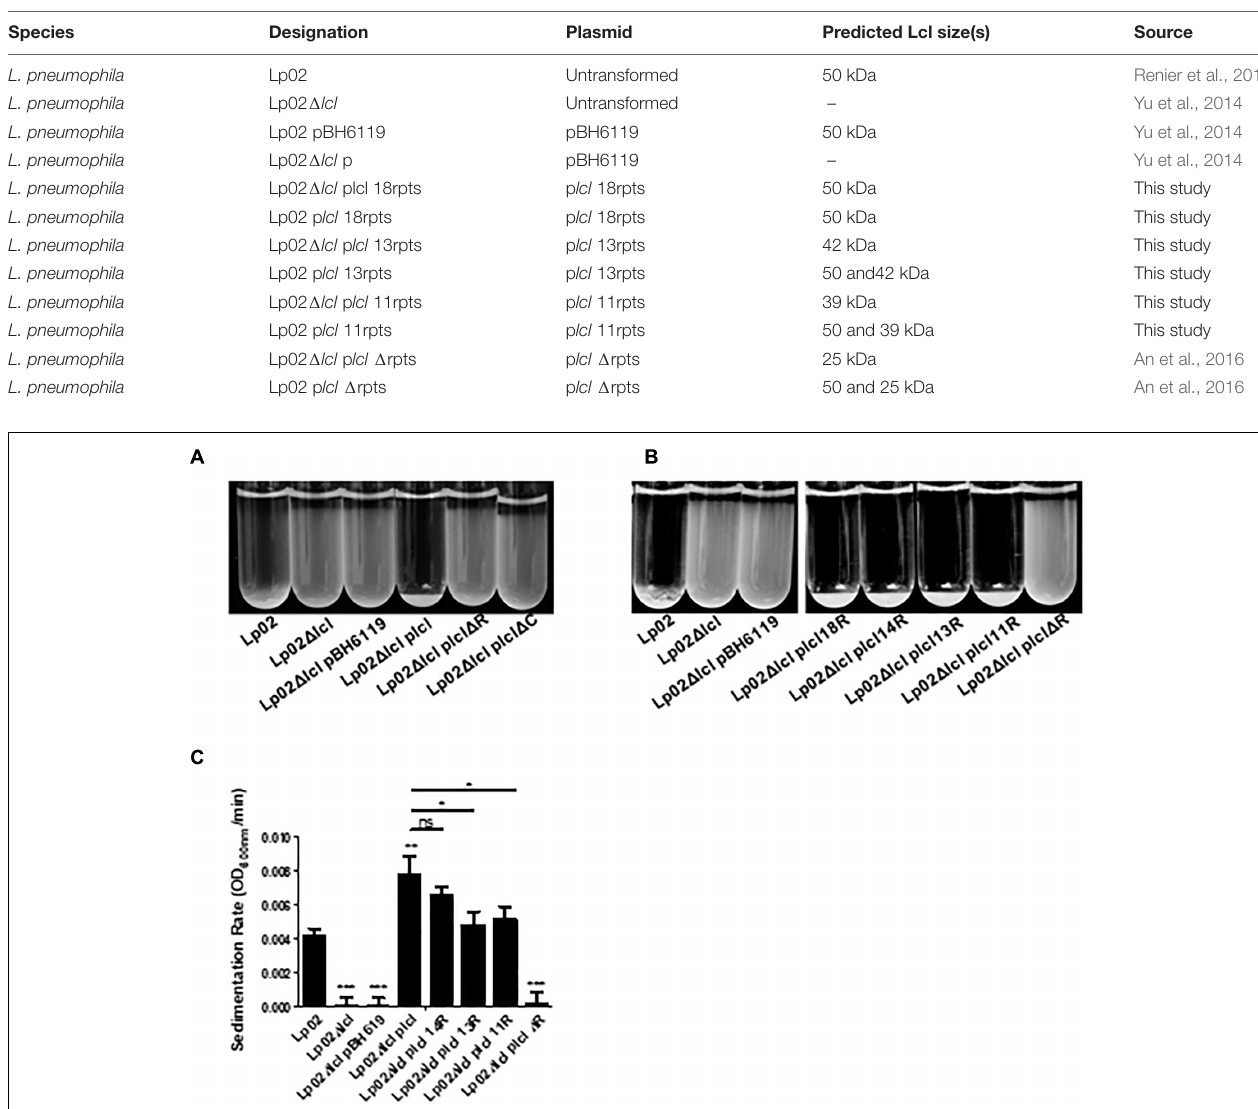
TABLE 1 | Legionella pneumophila lab strains used in this study.